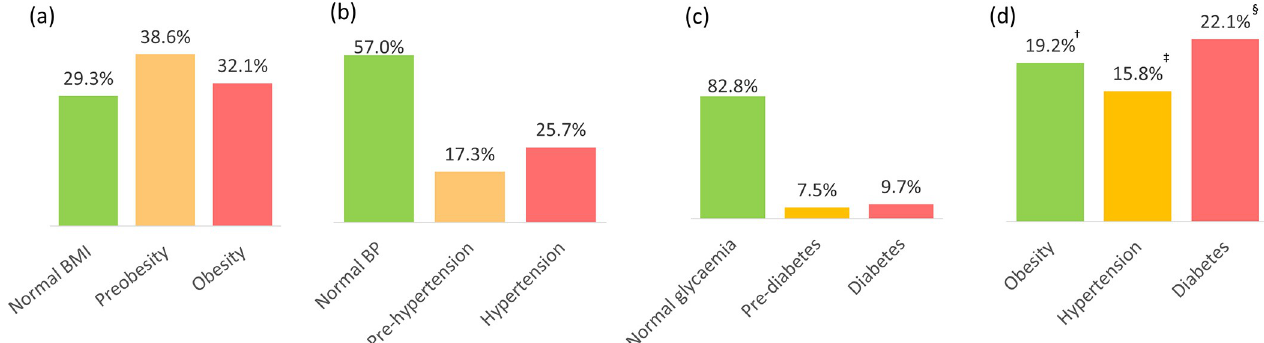
Fig 1. Prevalence of non-communicable diseases and pre-disease stages detected by MIDO COVID (N = 58,277): (a) obesity, (b) hypertension, and (c) diabetes. Percentages of patients previously aware of their condition are shown in (d). † N = 18,718. ‡ N = 14,950. § N = 5,659. Abbreviations: BMI, body mass index; BP, blood pressure; MIDO, Integrated Measurement for Early Detection.